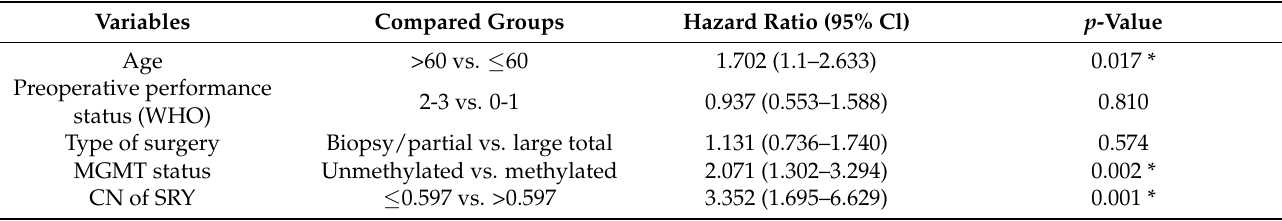
Table 2. Multivariate analysis results. We included 104 samples with SRY CN data (for 1 sample we did not obtain the result) in the multivariate analysis and compared the influence of different prognostic factors on OS. Deletions of SRY have the most significant influence on